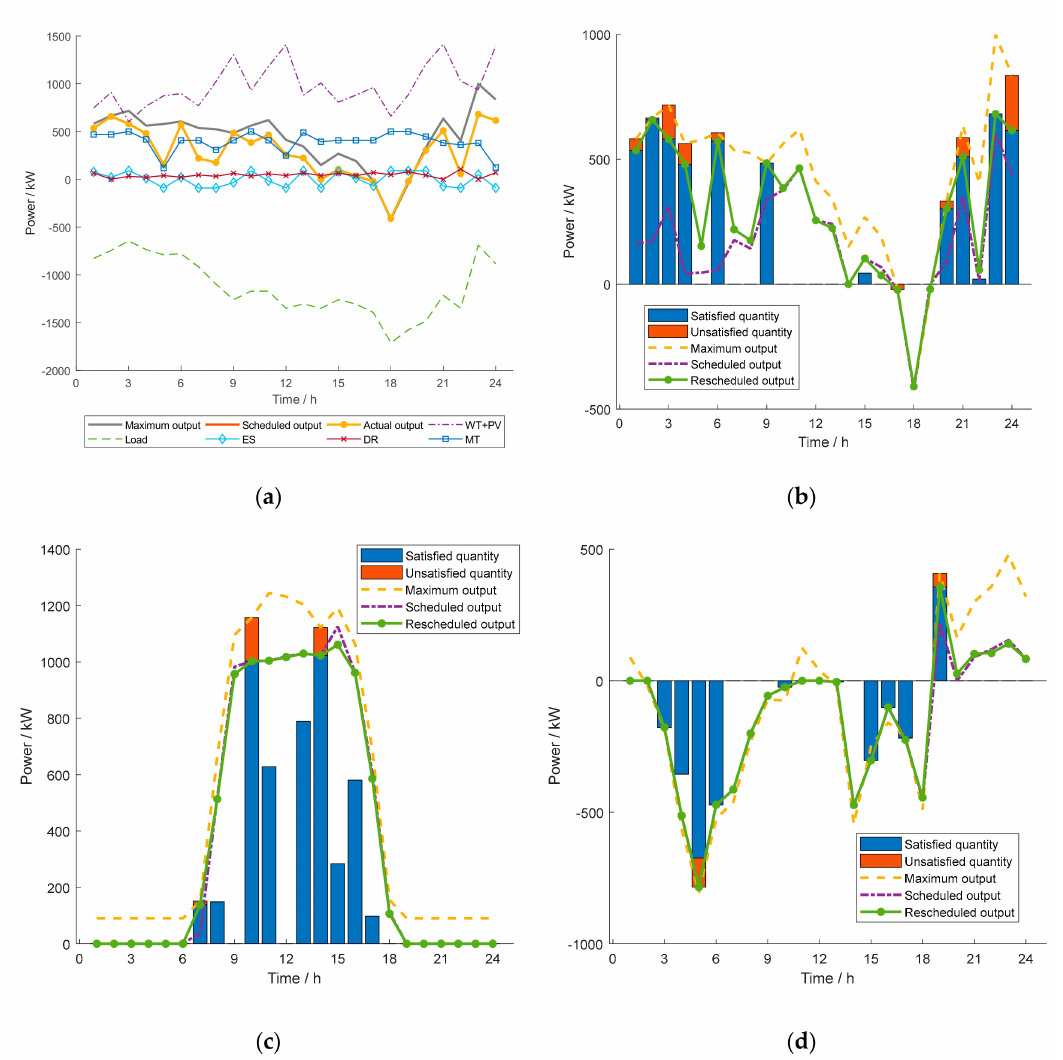
Figure 9. Changes in the output and P2P trade quantity of a VPP after rescheduling in the first round of negotiations ( R = 1): ( a ) The detailed result of rescheduling VPP 1 ; ( b ) changes in the output and P2P trade quantity of VPP 1 after rescheduling; ( c ) changes in the output and P2P trade quantity of VPP 6 after rescheduling; ( d ) changes in the output and P2P trade quantity of VPP 7 after